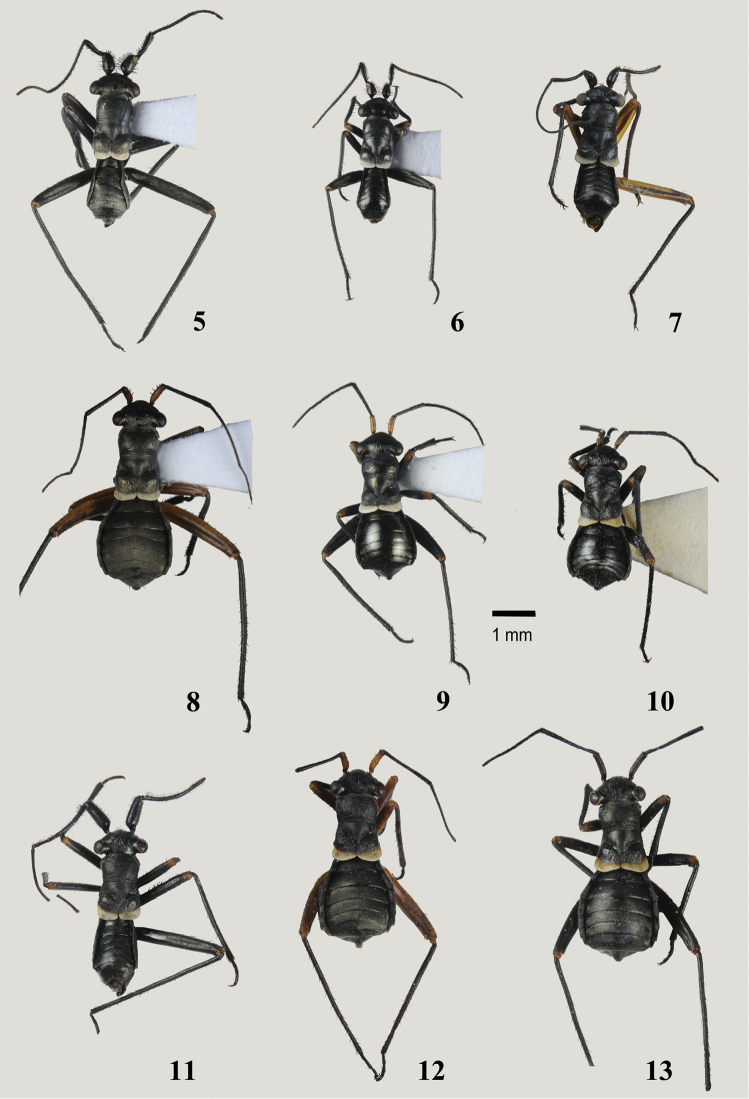
Dorsal habitus of Myrmecophyes (Plumiger) species. 5, 8Myrmecophyesarmeniacus Drapolyuk, 1989 5 male 8 female 6, 9Myrmecophyesheterocerus Horváth, 1927 6 male 9 female 7, 10Myrmecophyestomi sp. n. 7 male 10 female 11–13Myrmecophyesnasutus Drapolyuk, 1989 11 male 12 pale female 13 dark female.